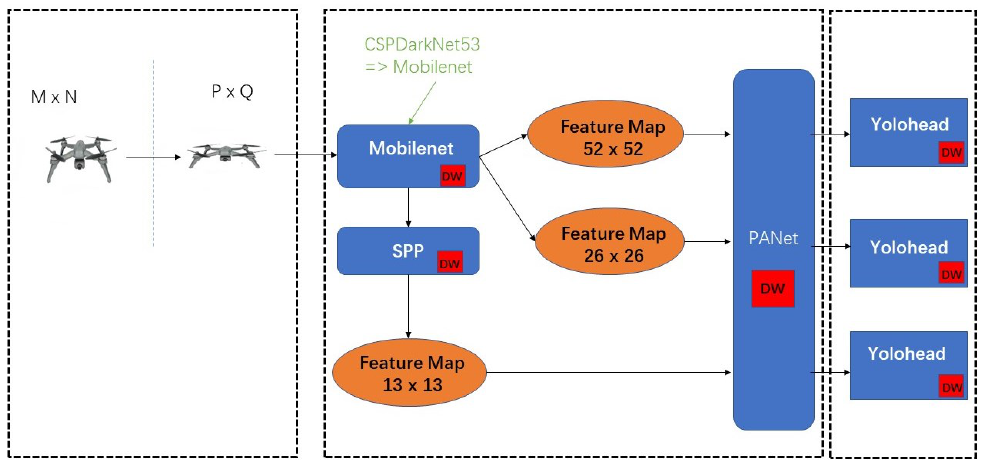
Figure 5. Lightweight YOLOv4 structure